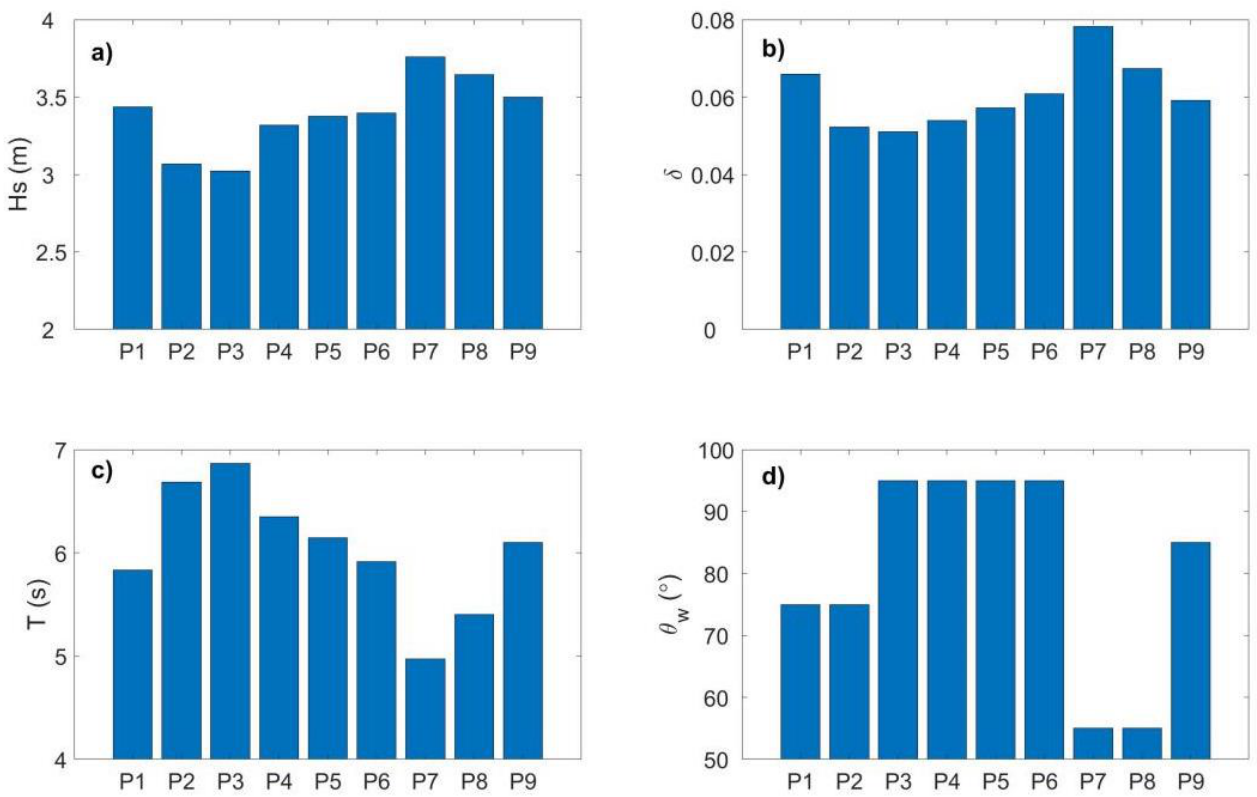
Figure 8. Wave parameters ( a ) H S , ( b ) δ , ( c ) T, and ( d ) θ w along the section shown in Figure 2 under Case 16.